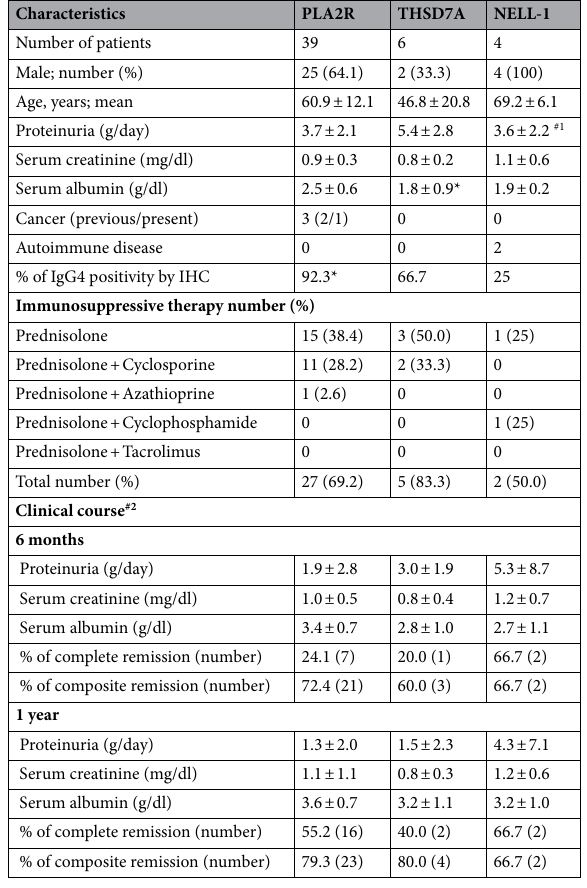
Table 2. Characteristics of each podocyte antigen-associated MN patients at the time of renal biopsy and treatment response. # 1; a case did not check the level of proteinuria before renal biopsy. #2; 10, 1 and 1 patients’ data in PLA2R-, THSD7A- and NELL-1-associated MN patients were not available because of follow-up in other hospitals. *p <